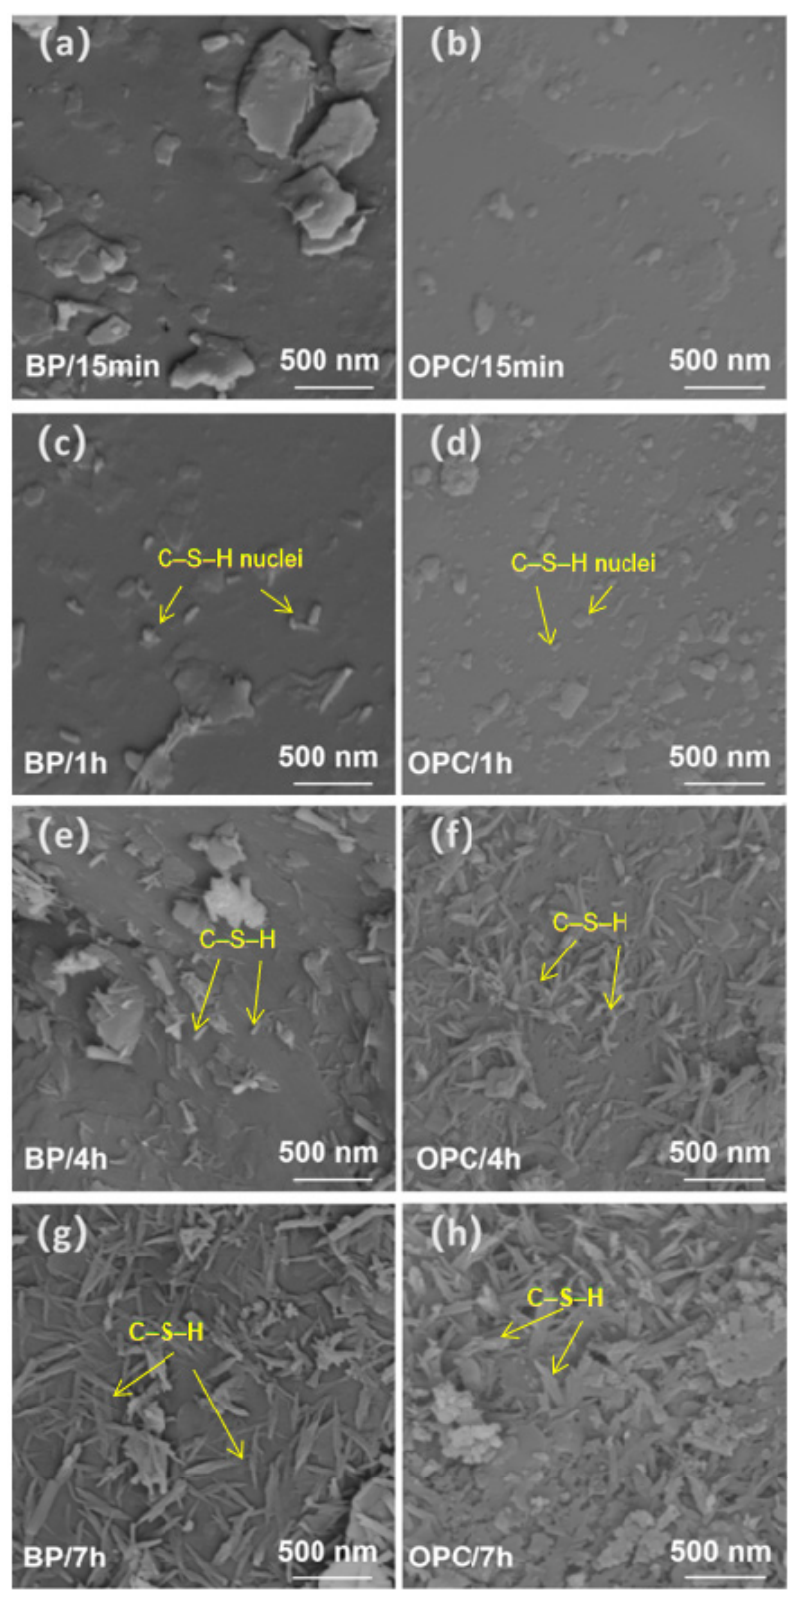
Figure 7. Hydrate morphology on the BP and OPC surface at 15 min ( a , b ), 1 h ( c , d ), 4 h ( e , f ) and 7 h ( g , h